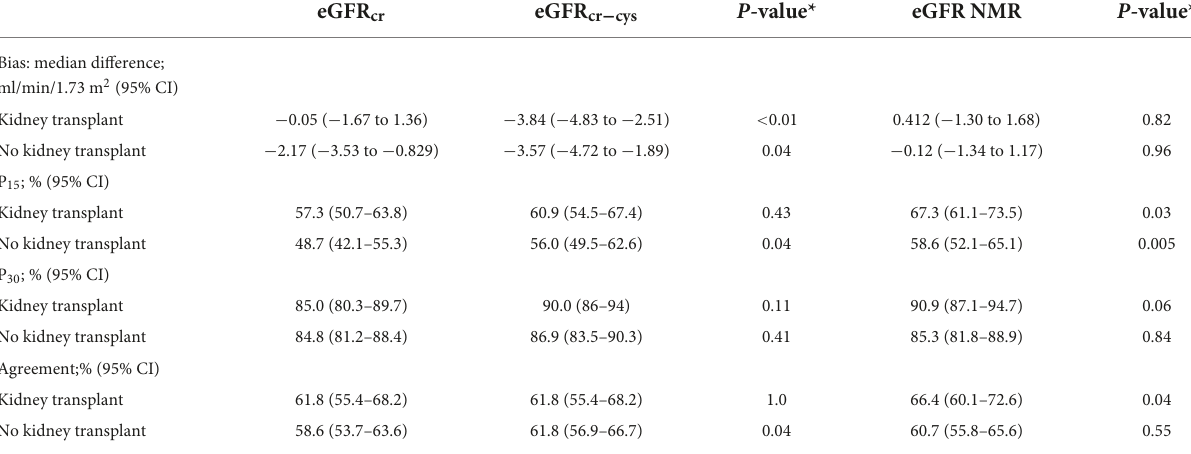
TABLE 2 Method comparison for estimated versus measured GFR by eGFR equation and kidney transplant status.